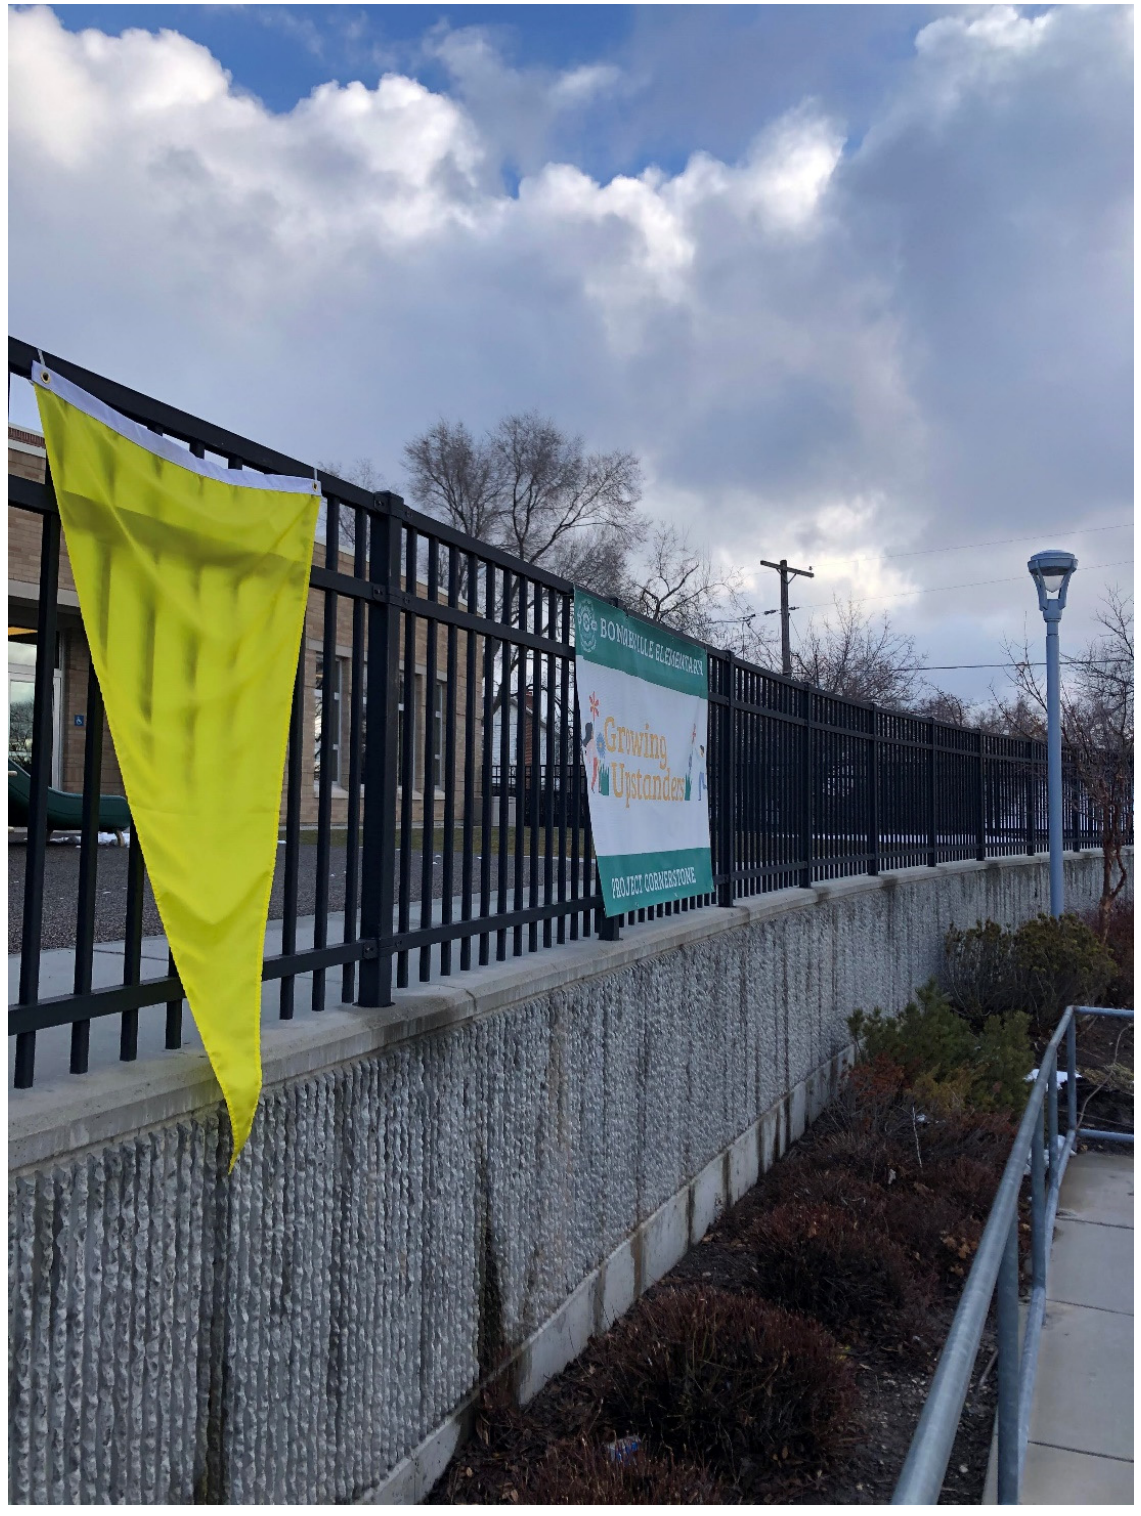
Figure A16. Air quality index (AQI) flag display in front of Bonneville Elementary School.